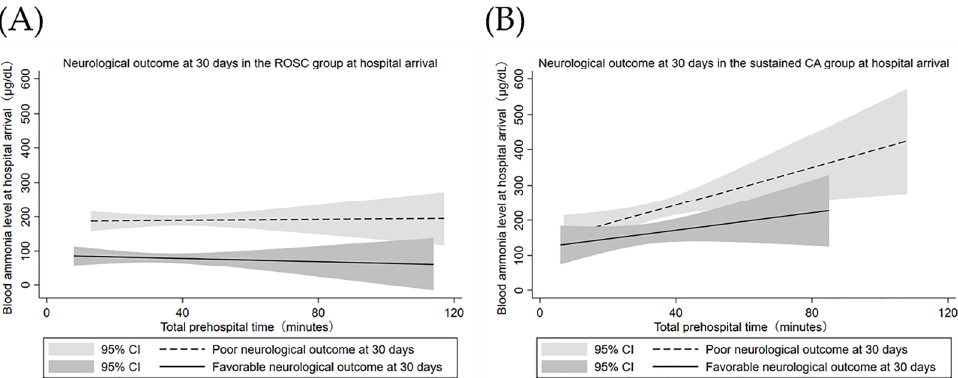
Figure 4. Relationship between blood ammonia level at hospital arrival and total prehospital time in the ROSC group ( A ) and the sustained CA group ( B ). In the ROSC patients, the blood ammonia levels of each outcome were almost constant regardless of total prehospital time. The blood ammo- nia level was lower in patients with favorable outcomes compared to those with poor outcomes. In the sustained CA patients, blood ammonia levels continued to increase in correlation with transpor- tation time for both outcomes. Abbreviations: return of spontaneous circulation (ROSC); cardiopul- monary arrest (CA); confidence interval